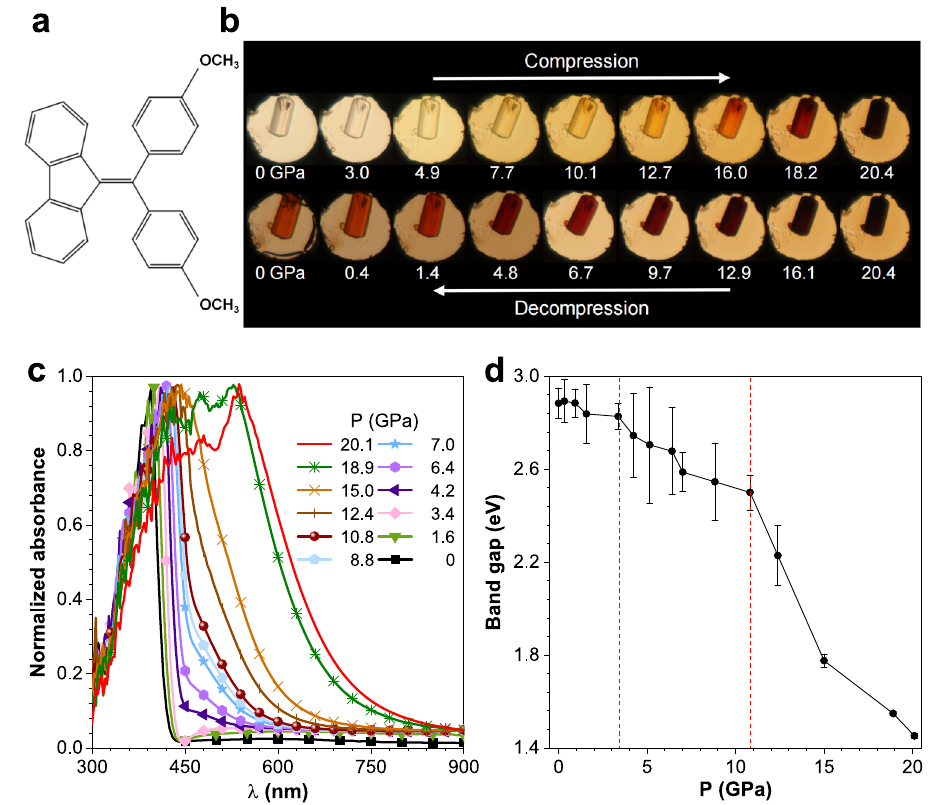
Fig. 1 | Absorption characterization of FTPE crystal under pressure. a Atomic structure of FTPE molecule. b Images of FTPE single crystal during compression anddecompressionprocesses(0GPaindicatesambientpressure).Insitu( c )UV – vis